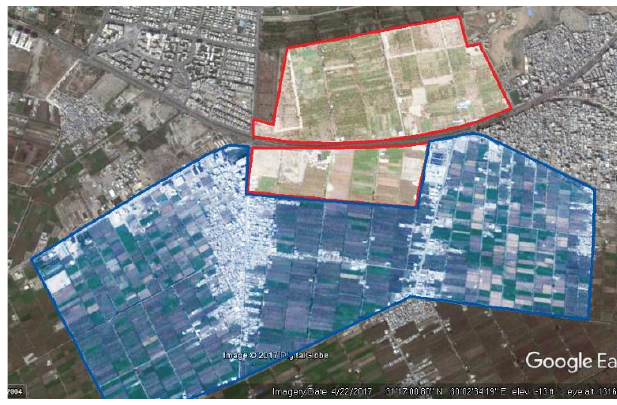
Figure 10: Areas of different land tenure form in Al- Maamoura - Source: Researcher based on Google